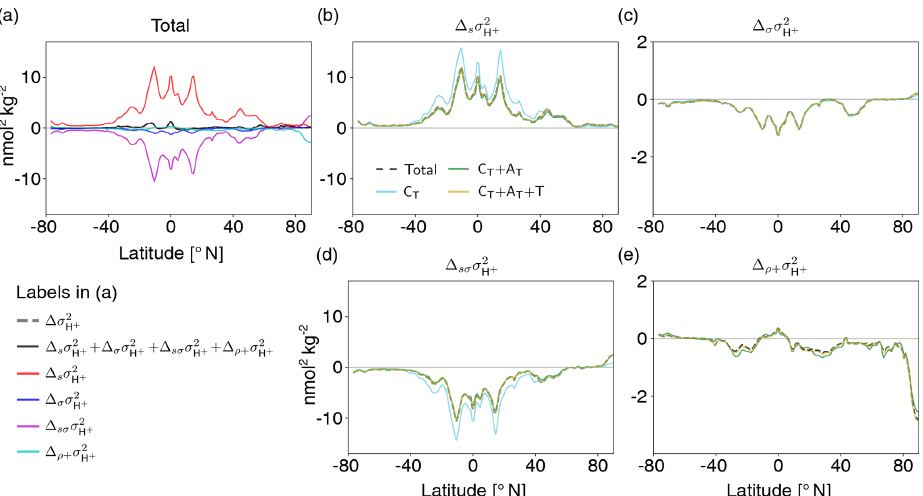
Figure 10. Decomposition of [H + ] variability changes at 200m into different drivers ( C T , A T , temperature, and salinity). Shown are changes from the preindustrial period to 2081–2100 following the RCP8.5 scenario. The simulated change in [H + ] variance ( (cid:49)σ 2 into the contribution from changes in the sensitivities that arise from changes in the drivers’ mean values ( (cid:49) s σ 2 changes in the drivers’ standard deviations ( (cid:49) σ σ 2 ), the contribution from simultaneous changes in the sensitivities and the drivers’ standard H + deviations ( (cid:49) sσ σ 2 ), and the contribution from correlation changes alone together with simultaneous changes in correlations and sensitivi- H + ties and standard deviations ( (cid:49) ρ + σ 2 ) (a) . The contributions to these components from changes in C T alone (light blue lines); from changes H + in C T and A T (green lines); and from C T , A T , and temperature (gold lines) are shown in panels (b) – (e) . The dashed black lines in panels (b) – (e) show the total components that contain contributions from all four drivers.